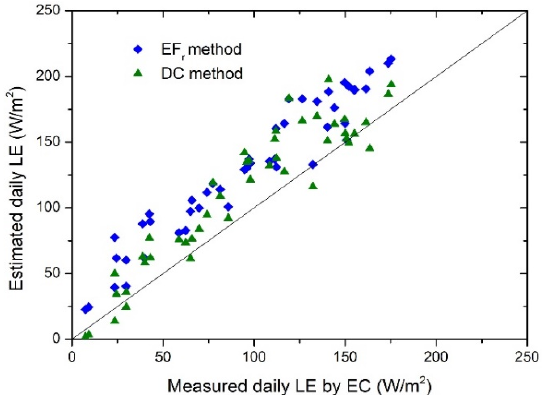
Figure 4. Validations of daily ET estimations calculated by the DC method and temporal upscaled by the constant EFr method against with the original ET measurements. Table 1. Statistical items of daily ET estimations calculated by the DC method and temporal upscaled by the constant EFr method, validated with uncorrected and corrected EC